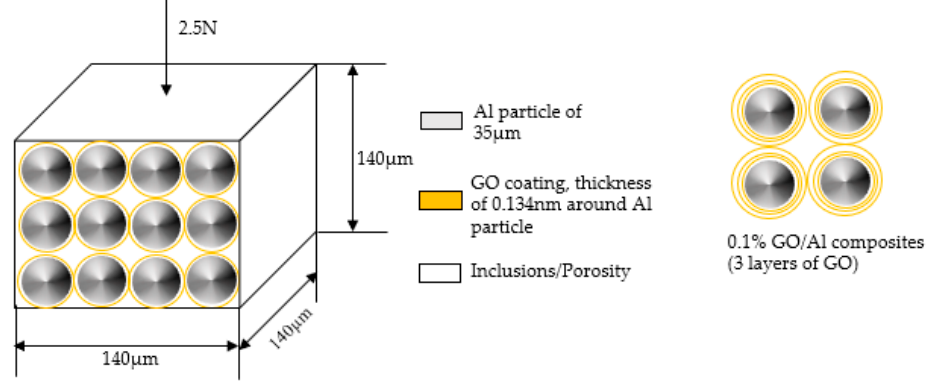
Figure 3. Representation of GO / Al composite with monolayer of GO reinforcement (40% porosity) and 3 layers of GO reinforcement (32% porosity) on Al particles.